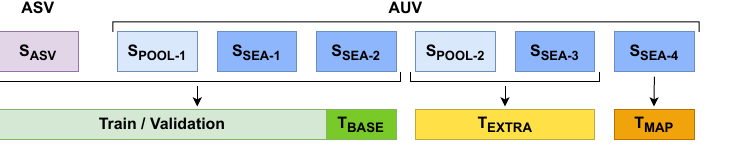
Figure 4. Dataset management.